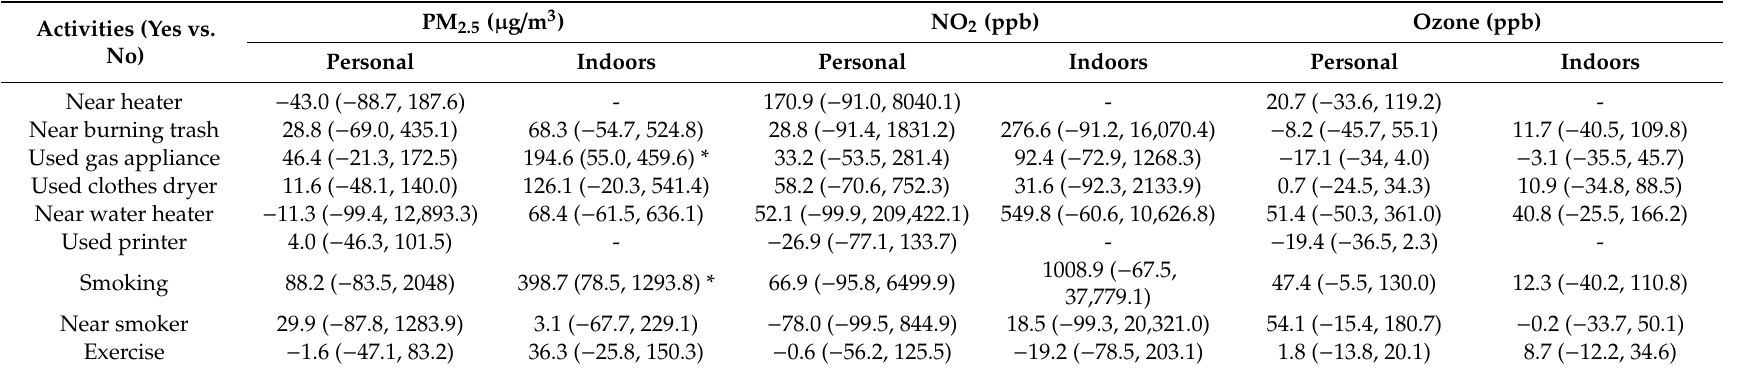
Table 3. Percent di ff erence (and 95% confidence intervals) in air pollutants associated with specific daily activities. Activities (Yes